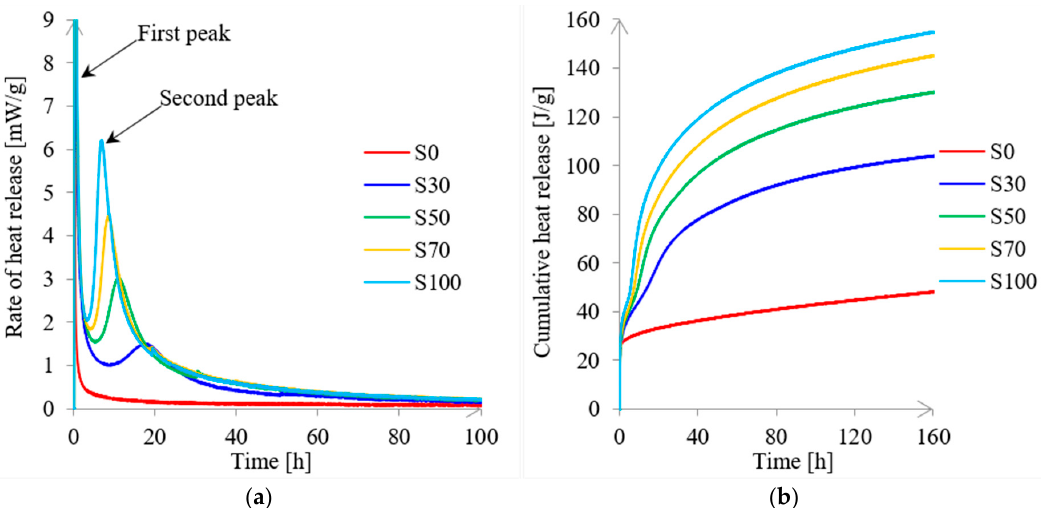
Figure 9. Calorimetric curves for the rate of heat release ( a ) and cumulative heat release ( b ) for alkali- activated pastes with l/b = 0.5.